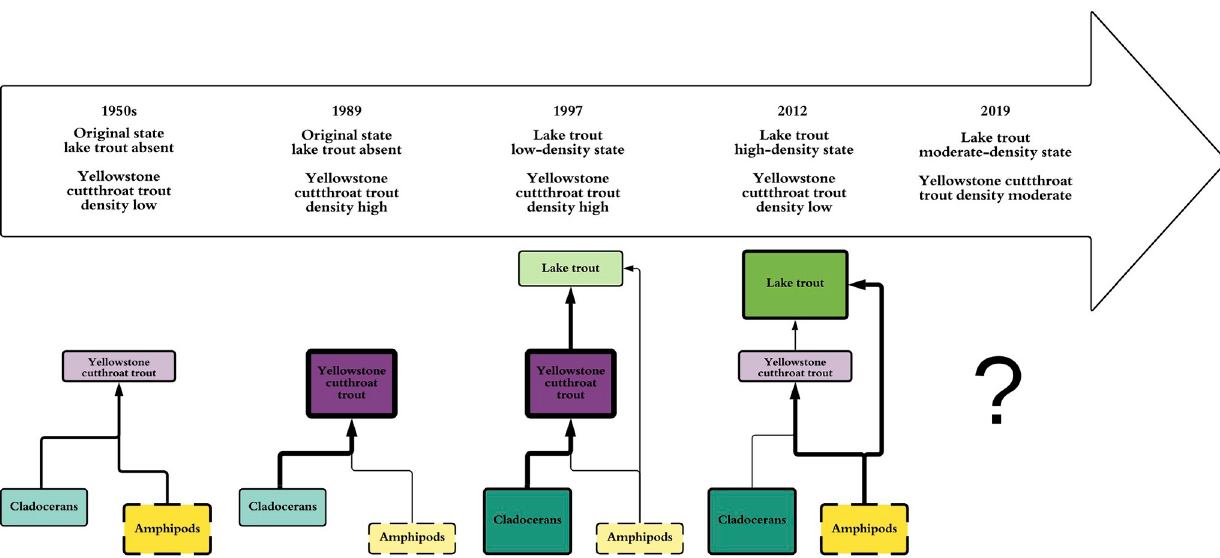
Fig 1. Timeline of simplified trout diets. Historical representations of Yellowstone cutthroat trout and > 300 mm lake trout diets before lake trout invasion, and during two stages of lake trout density, with the current diet composition unknown during a moderate-density state of lake trout. Size, color intensity, and thickness of solid-lined boxes represents relative densities of organisms, thickness of lines represents relative contributions of organisms to predator diet, and size, color intensity, and thickness of dashed boxes represents inferred density of organisms based on previous research. Diet data for the 1950s are from Benson [44], data for 1989 are from Jones et al. [46], data for 1997 are from Ruzycki et al. [54], and data for 2012 are from Syslo et al. [53]. Relative abundances of lake trout are from Syslo et al. [55]. Lake trout absent is a state with no detectable density, low-density state is ~80,000 > 300 mm lake trout, high density is ~450,000 > 300 mm lake trout, and moderate-density state is ~300,000 > 300 mm lake trout. Relative abundances of Yellowstone cutthroat trout are from Koel et al. [40]. Relative abundances of cladocerans are from Tronstad et al. [21], and relative abundances of amphipods are inferred from Wilmot et al.